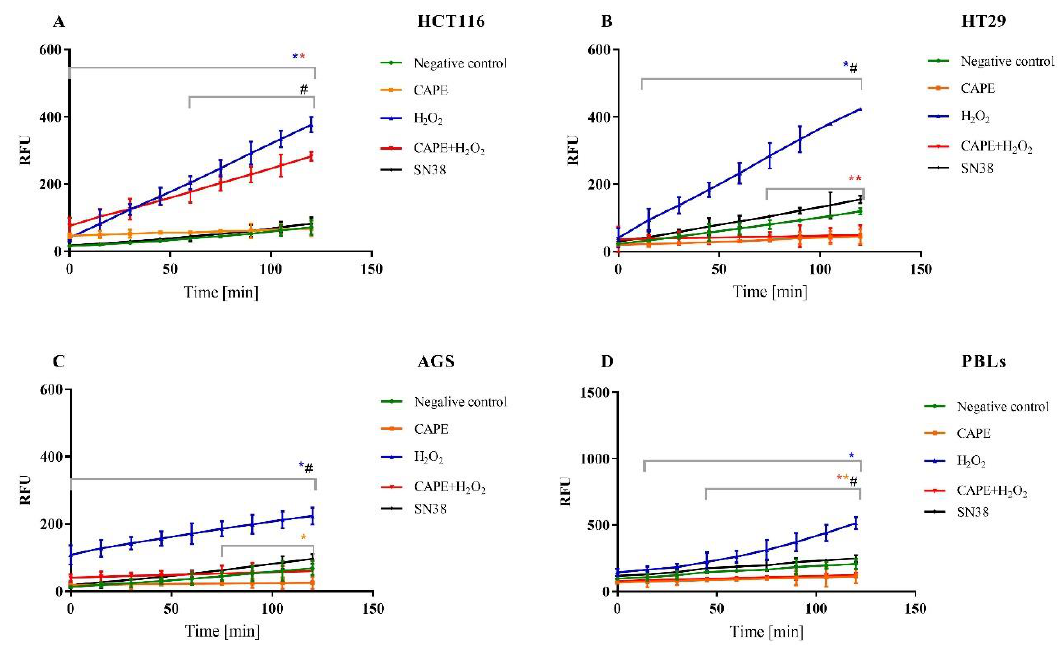
Figure 8. ROS generation in HCT116 ( A ), HT29 ( B ), AGS ( C ) cells and PBLs ( D ). The series with the preincubation with CAPE. The concentration of CAPE used in experiment was the IC 50 value determined for each cancer cell line and for PBLs were used the highest concentration from all designated. * p < 0.05 as compared with control (untreated) cells; # p < 0.05 as compared cells treated H 2 O 2 with cells treated CAPE + H 2 O 2.